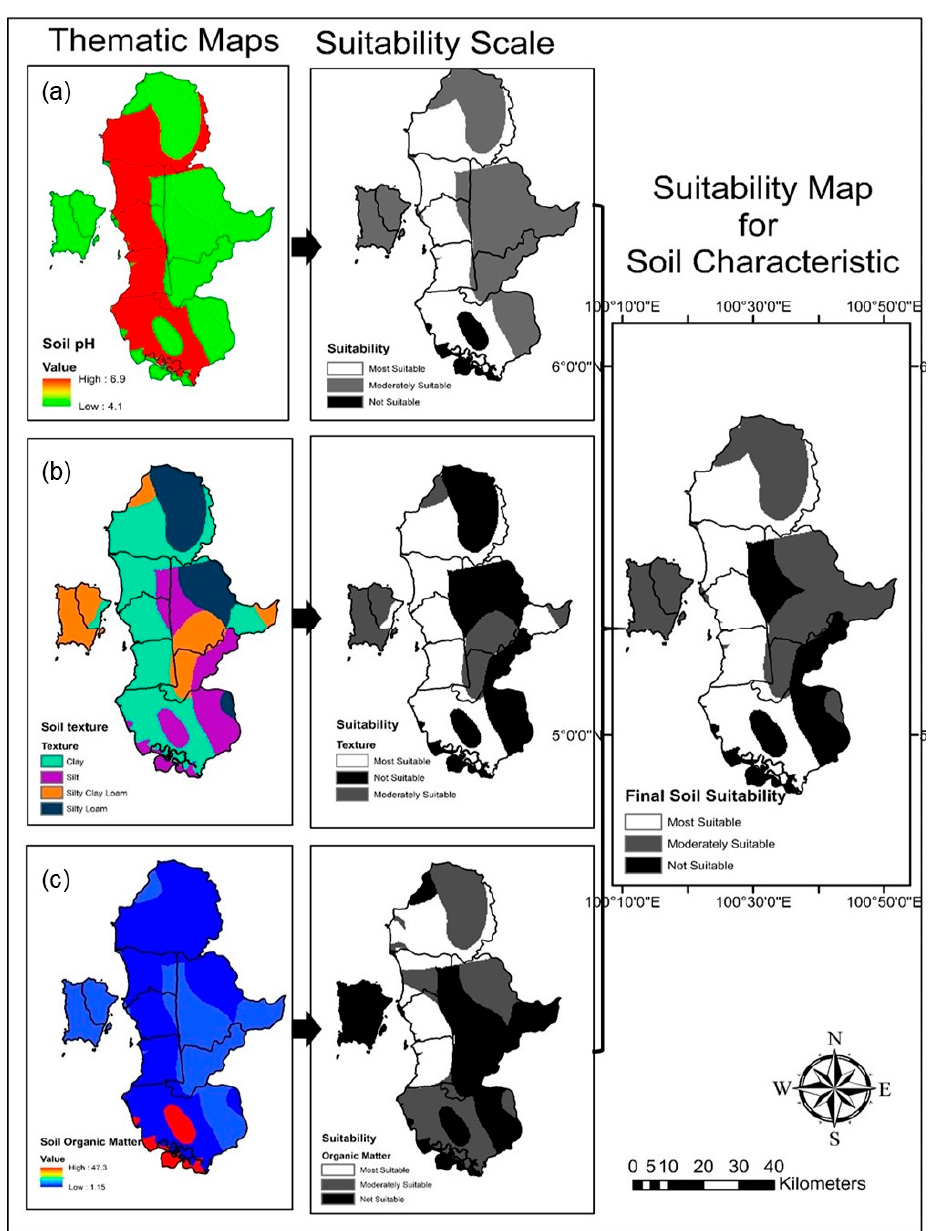
Figure 3. Process of producing a suitability map for soil characteristics from ( a ) soil pH, ( b ) soil texture, and ( c ) soil organic matter.